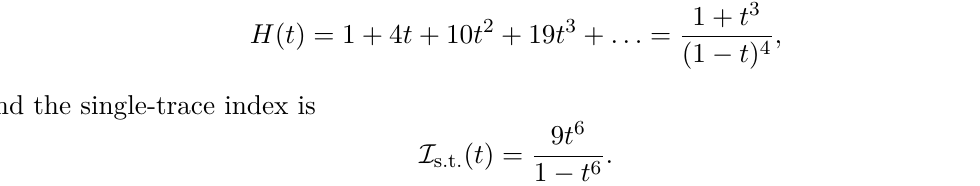
Table 2 . Counting of operators in field theory dual to T 1 , 1 graded by k . Note that the number of tr( W α W α O ) operators, except for the case of k = 0 , is the same as the number of tr( O ) operators after a shift of k by 3. There are two modes for tr( W α W α O ) at k = 3 since b 2 + 1 = 2 for T 1 , 1 . where 3 k = s and s takes integer values. Thus it is natural to write the Hilbert series as ˜ H ( t ) = H ( t 6 ) , giving, for the undeformed